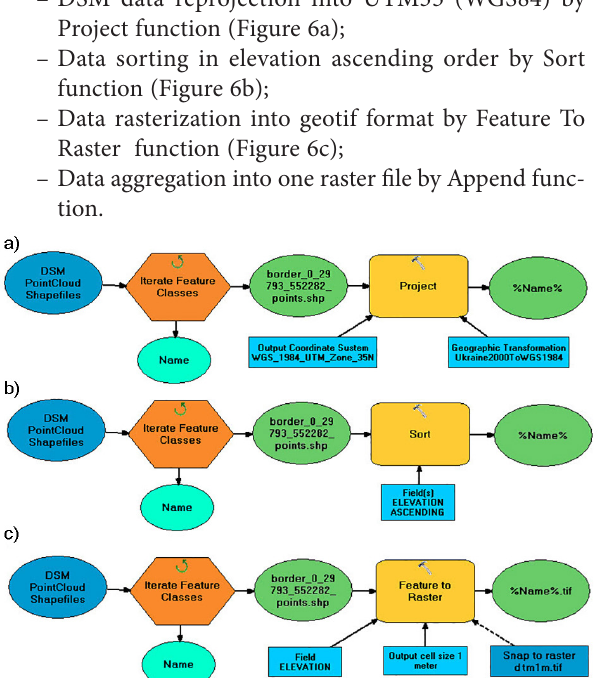
Figure 5. The clutter height production technological scheme